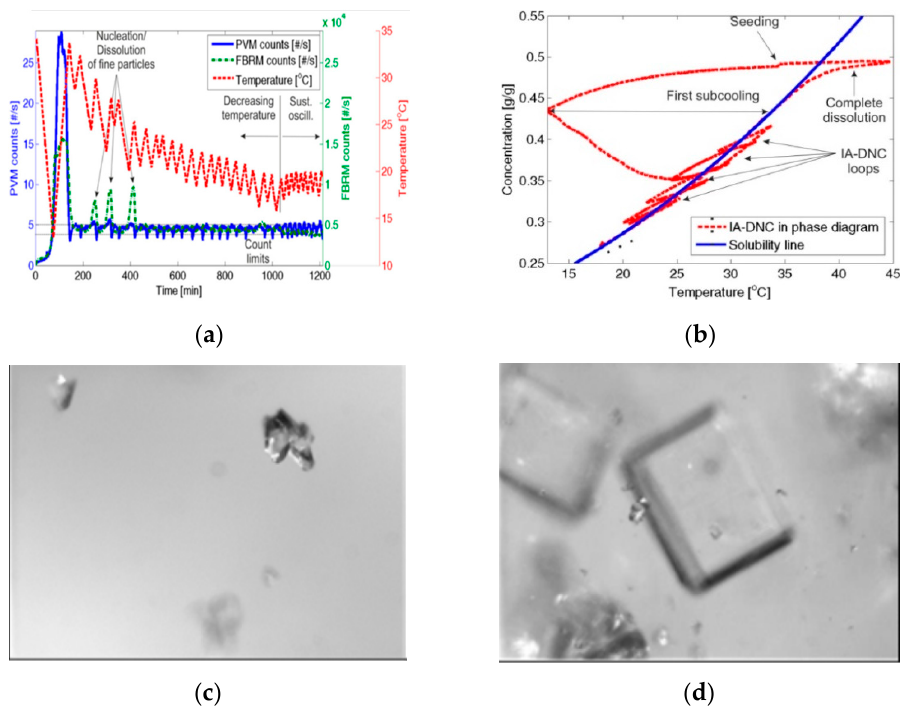
Figure 5. Temperature, focused beam reflectance measurement (FBRM) counts per second, and concentration profiles overtime during an image analysis based direct nucleation control (IA-DNC) experiment ( a ); a corresponding operating curve in the crystallization phase diagram ( b ); PVM images during the first nucleation process ( c ); in-situ particle vision and measurement (PVM) picture of product crystals from the IA-DNC experiments ( d ). (Caption and figure reprinted with permission from Reference [37]).